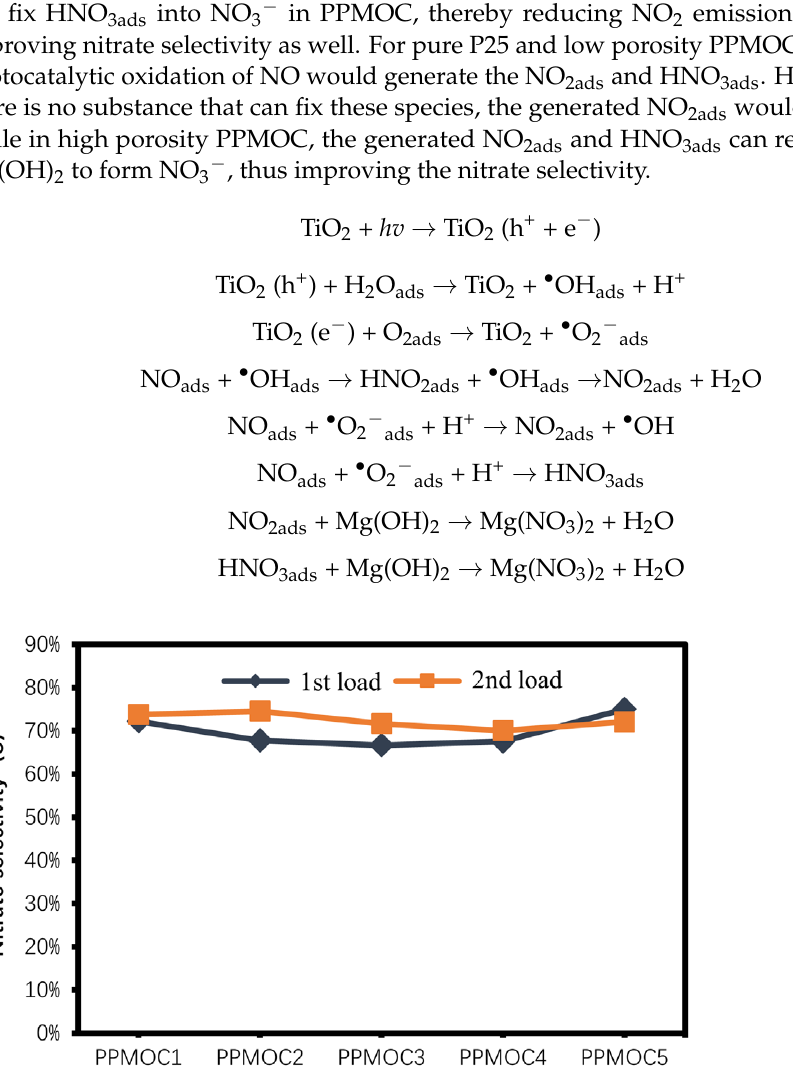
Figure 7. Effect of PPMOC loading times on nitrate selectivity. The PPMOC number in x axis means different porosity (shown in the experimental section).